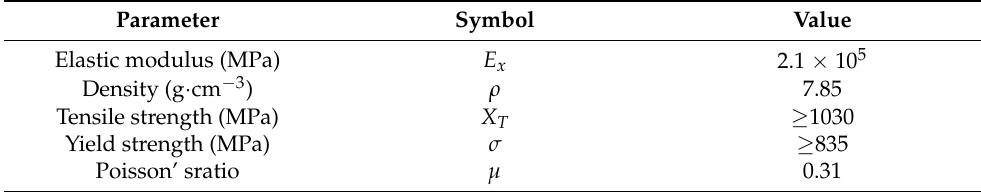
Table 2. Performance parameters of cutting